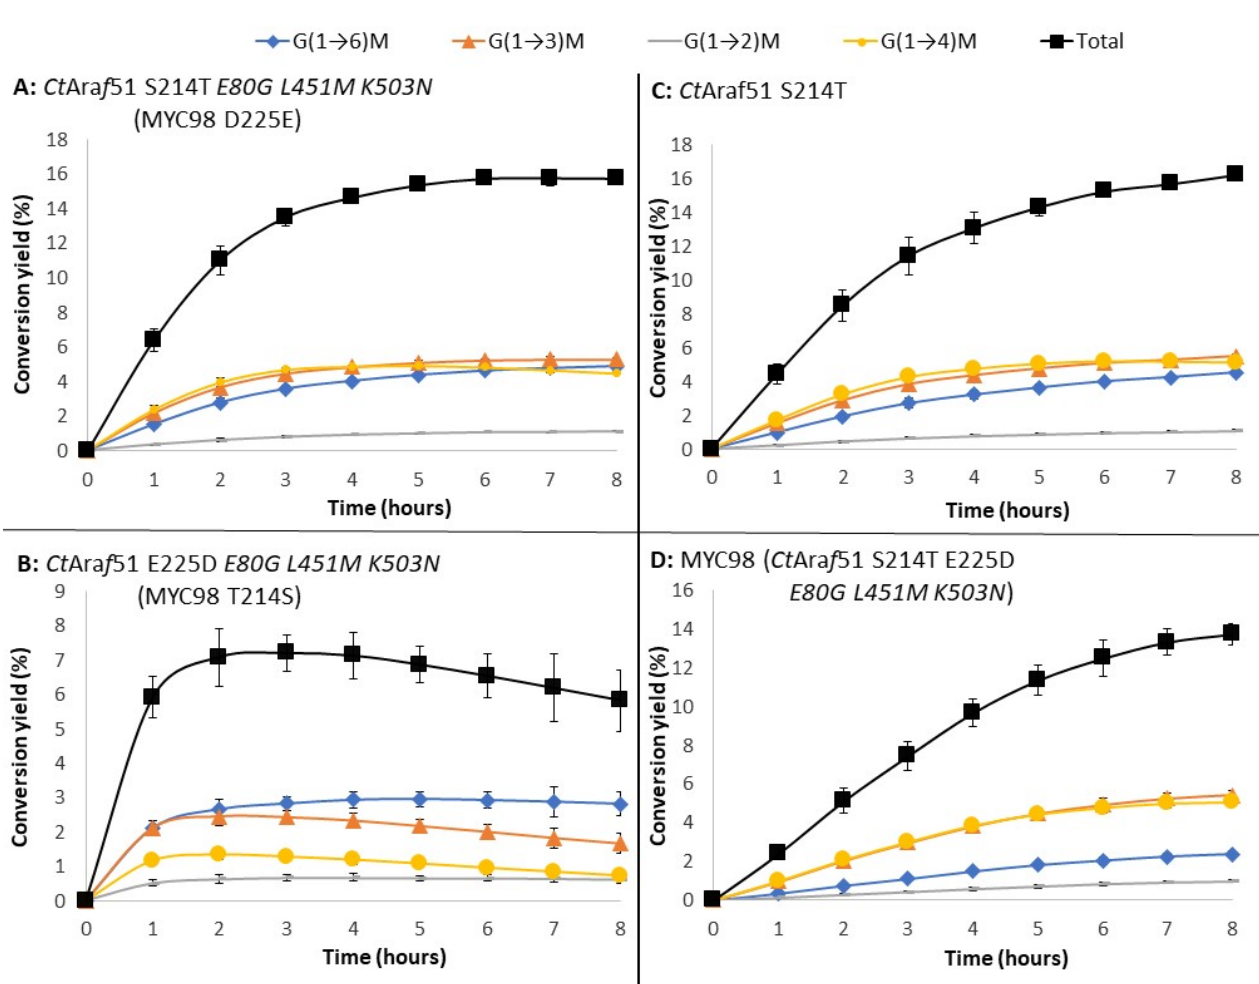
Figure 5. Transglycosylation kinetics with the mutant MYC98 and its derived mutants (( A ): MYC98 D225E, ( B ): MYC98 T214S, ( C ): Ct Ara f 51 S214T, ( D ): MYC98). Mutations labelled in italic have no influence either on the transglycosylation yield nor on the regioselectivity. A total of 10 mM of Gal f ‐ octyl and 60 mM of Man p ‐ p NP were used at 60 °C. The error bars represent the standard deviation of three independent experiments.